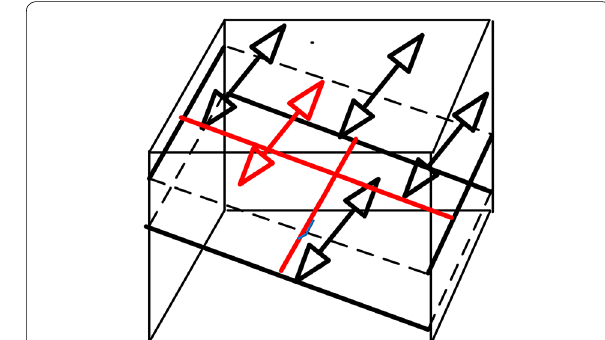
Figure 11 F&C line graph scheme of moving